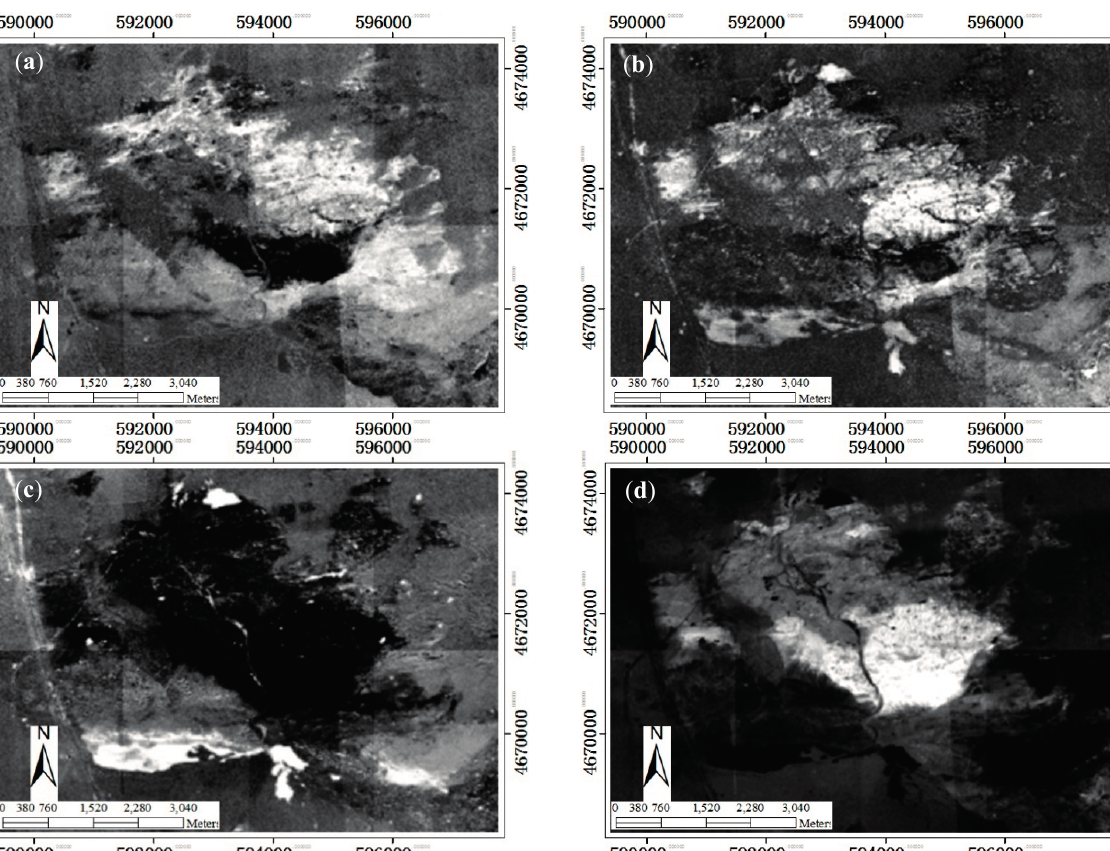
Figure 6. Alteration minerals by SAI extracted from HyMap data of Copper-mine area. ( a ) is the alteration mineral SAI image related to Al-poor muscovite, ( b ) is the alteration mineral SAI image related to Al-rich muscovite, ( c ) is the alteration mineral SAI related to antigorite information and ( d ) is the alteration mineral SAI image related to epidote